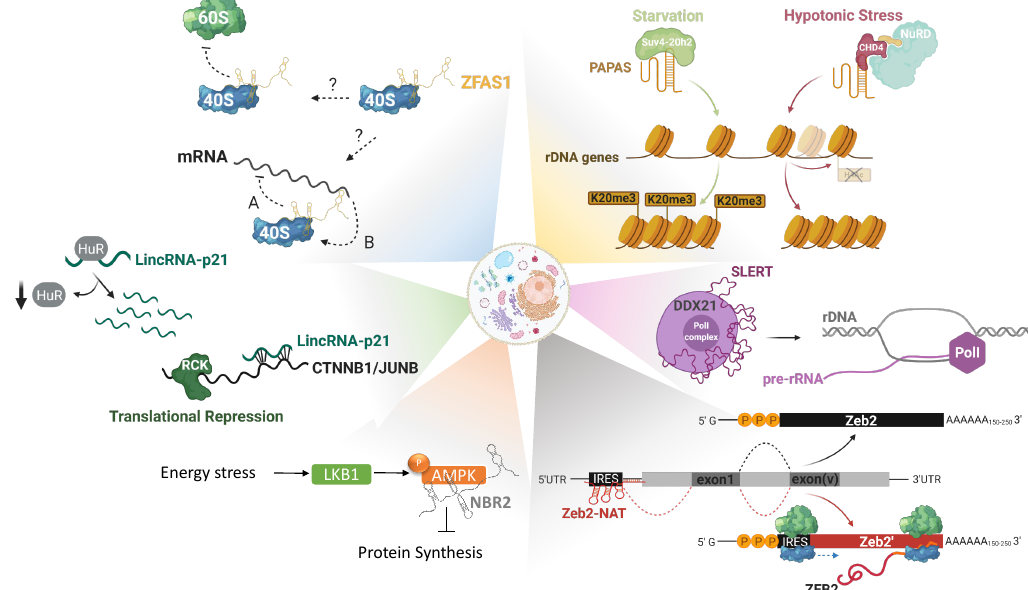
Figure 2. LncRNAs in translation regulation. In the nucleus, lncRNAs PAPAS and SLERT regulate ribosome biogenesis through regulation of rRNA transcription, while Zeb2-NAT by base-paring to its sense coding gene Zeb2 , causes inclusion of an IRES thus leading to its translation. In the cytoplasm, lncRNAs ZFAS1 binds the small ribosomal subunit and may have a role in mRNA translation. NBR2 attenuates global translation by interacting with AMPK and promoting its kinase activity. LincRNA-p21 regulates specific mRNA-targets by promoting their interaction with the translational